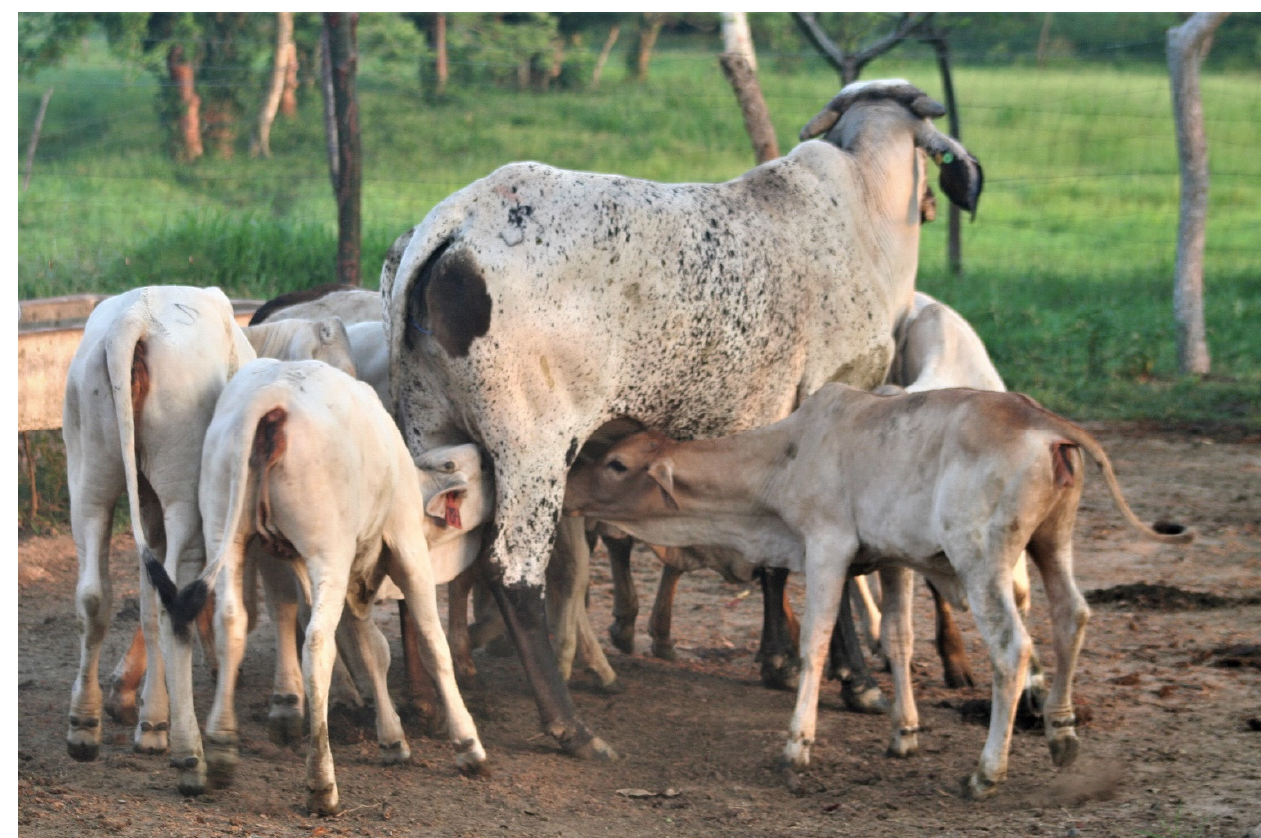
Figure 5. Even though, in most ungulates, cows develop exclusive care towards the young that they recognize in the first hours postpartum [56], some cows display no rejection to calves from other cows. In practice, these cows may be selected for the rearing of orphaned calves or for those whose mothers do not produce enough milk.